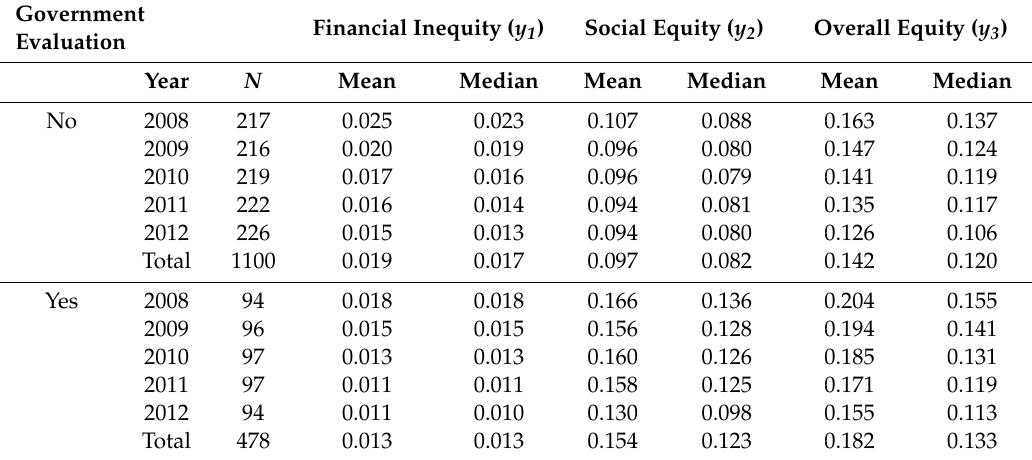
Table 6. Distribution of equity indicators (2008–2012) by government evaluation.